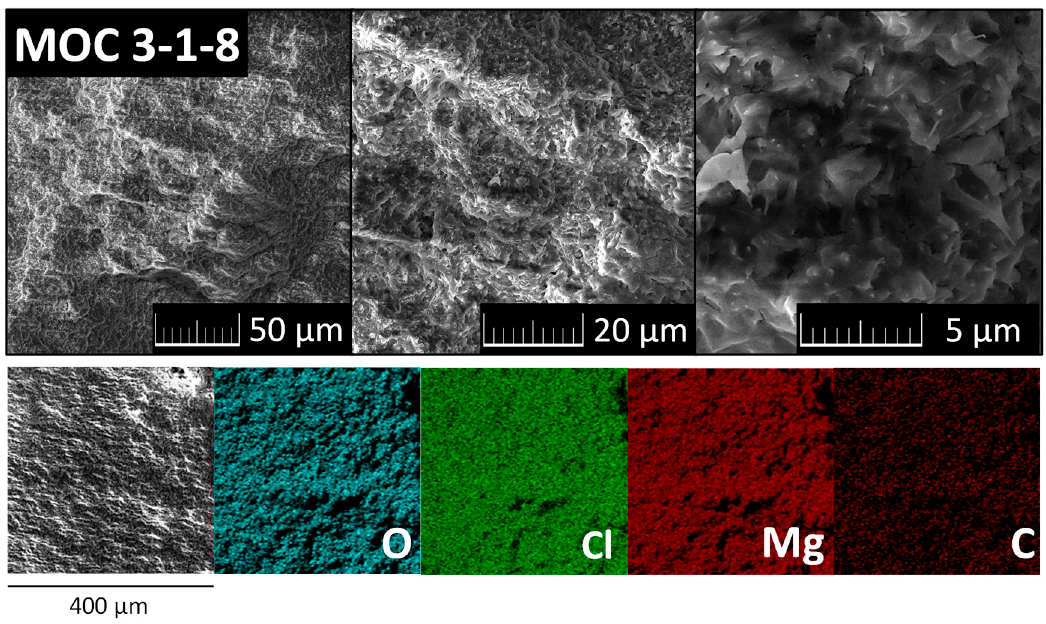
Figure 5. SEM micrographs and EDS elemental maps of MOC 3-1-8.